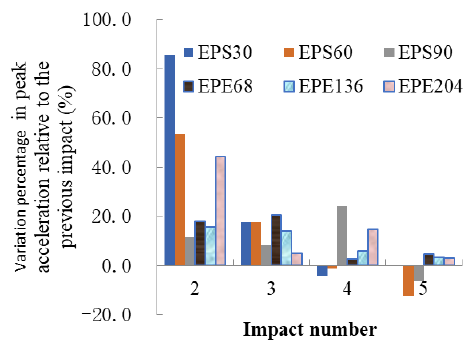
Figure 13. Reduction percentage of the peak accelerations of composite cushions relative to the pure sand cushion.